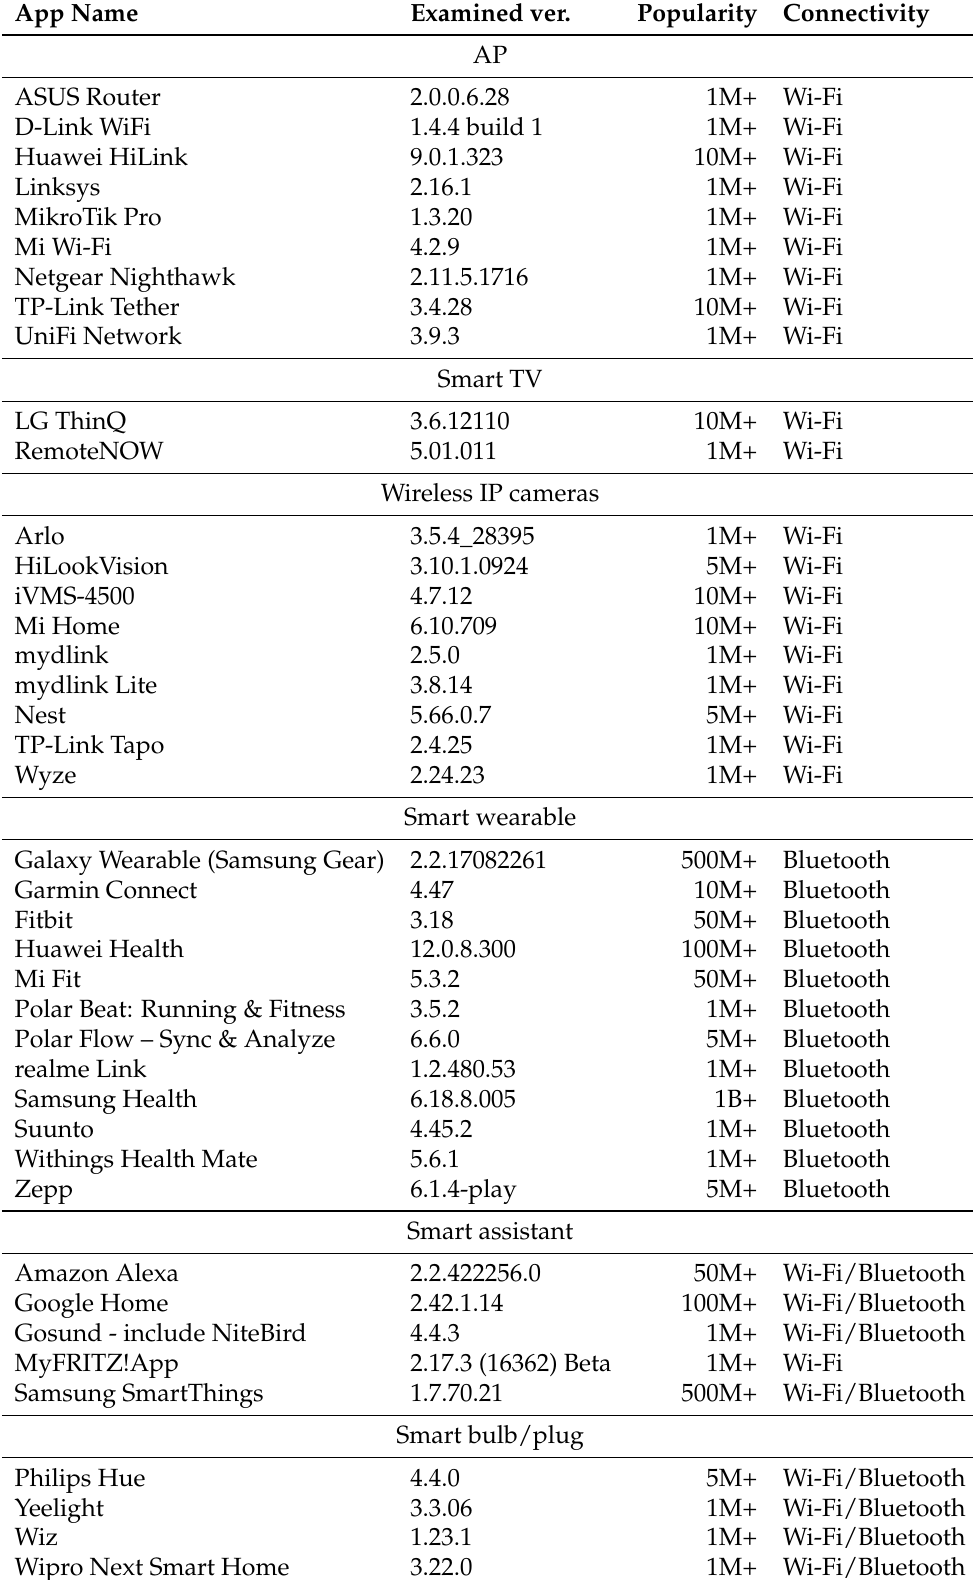
Table 1. Official management apps of popular IoT